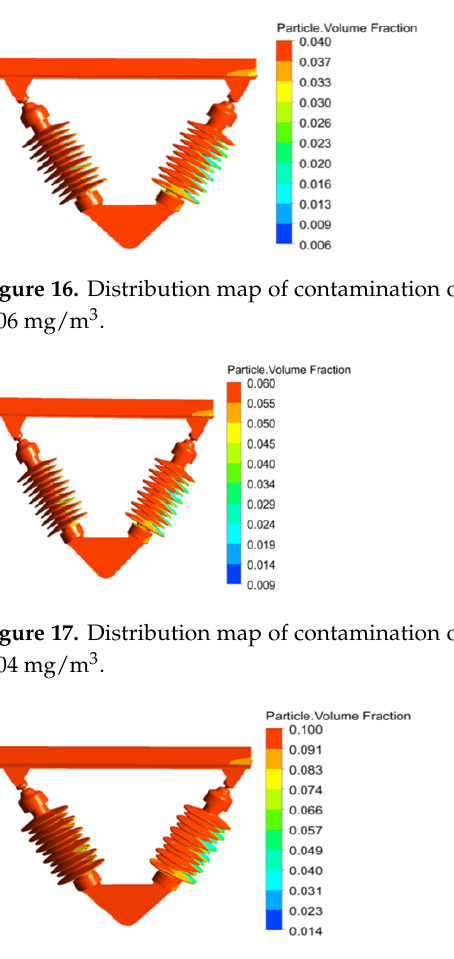
Figure 18. Distribution map of contamination on the surface of insulators with a concentration of 0.1 mg/m 3 .